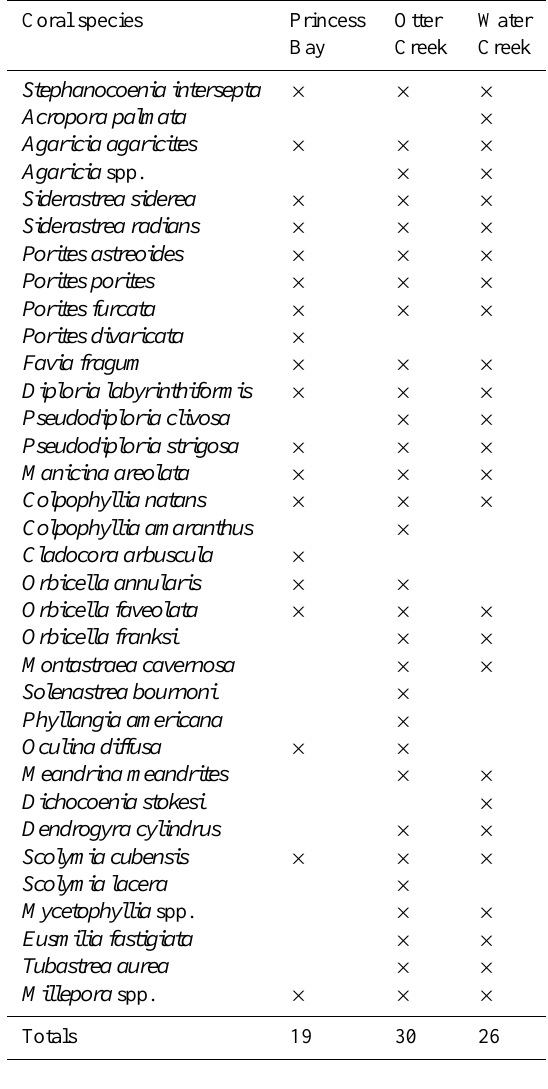
Table 1. Species list of corals living in